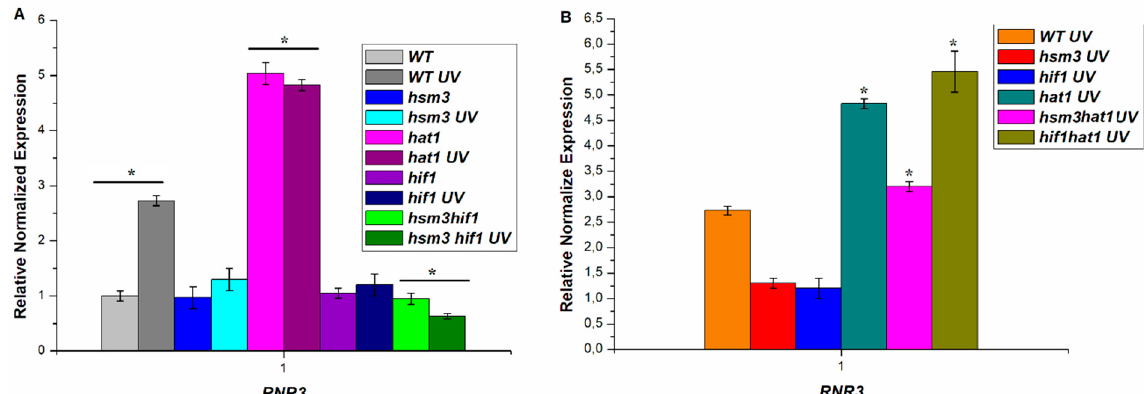
Figure 7. Relative normalized expression of the RNR3 gene, before and after irradiation with UV light of the corresponding strains (after UV irradiation, the cells were kept for two hours at 30 °C in a thermostat for induction), UV dose at 252 J/m 2 ; * p < 0.05, Student’s t test. ( A ) Relative normalized expression of the RNR3 gene, before and after irradiation with UV light; ( B ) Relative normalized expression of the RNR3 gene, after irradiation with UV light